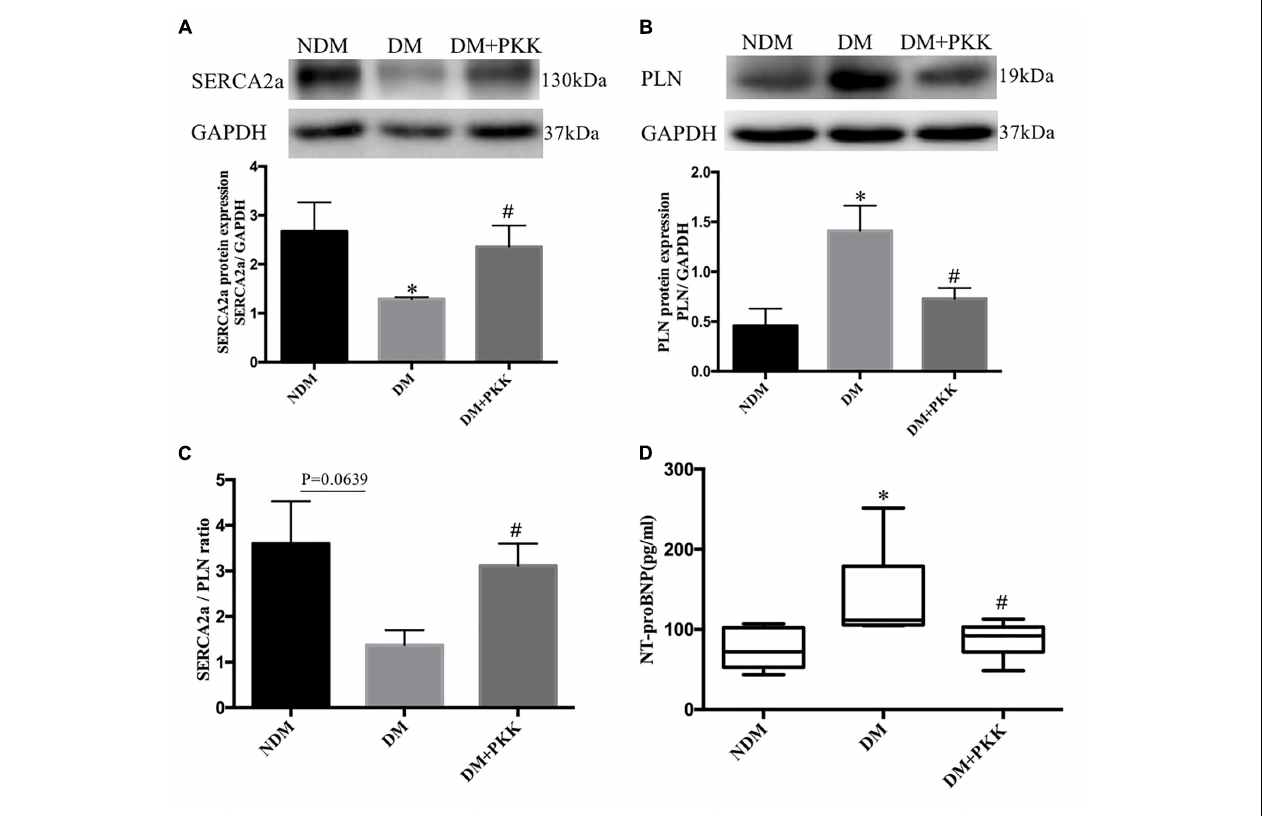
FIGURE 6 | Pancreatic kallikrein administration restored the expression of Ca 2 + -handling proteins in the heart of STZ-induced diabetic rats. (A,B) The protein expression and the quantitative data of SERCA2 and PLN examined using western blot. (C) The SERCA2/PLN ratio in myocardial tissues. (D) NT-proBNP plasma levels in the DM group were higher than in the NDM group and DM + PKK group. Each sample for western blot was repeated for three times. Values are mean ± SEM, n = 6 for per group; ∗ P < 0.05 vs. NDM group; # P < 0.05 vs. DM + PKK